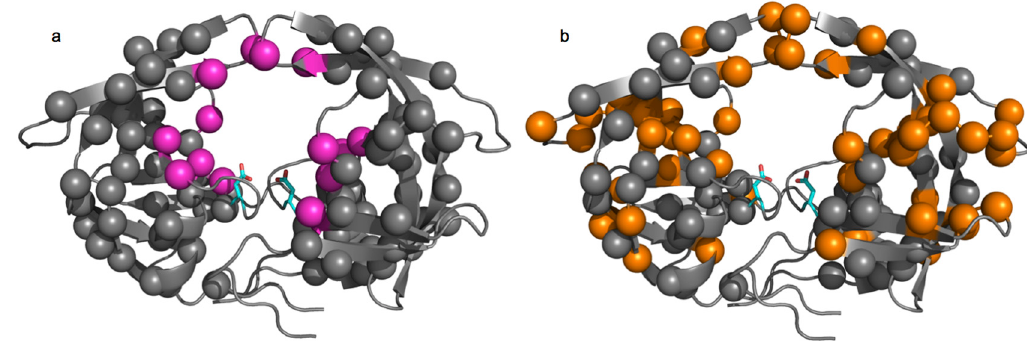
Figure 3. Location of drug resistance and conformational mutations in HIV ‐ 1 PR. Structural mapping of various mutations on the crystal structure of apo HIV ‐ 1 PR (1HHR). The catalytic Asp25 residue is depicted as cyan sticks on each enzyme protomer. All spheres represent a residue documented to undergo mutation in HIV ‐ 1 PR [97]. ( a ) Location of drug resistance ‐ inducing mutations. Magenta spheres represent mutations that impair inhibitor binding through direct active ‐ site contacts (primary mutations) and gray spheres represent distal indirect mutations (secondary mutations); ( b ) Location of mutations documented to affect the conformational sampling of HIV ‐ 1 PR, depicted as orange spheres. Gray spheres are other drug resistance ‐ inducing mutations. All mutations were compiled from references listed in the text.